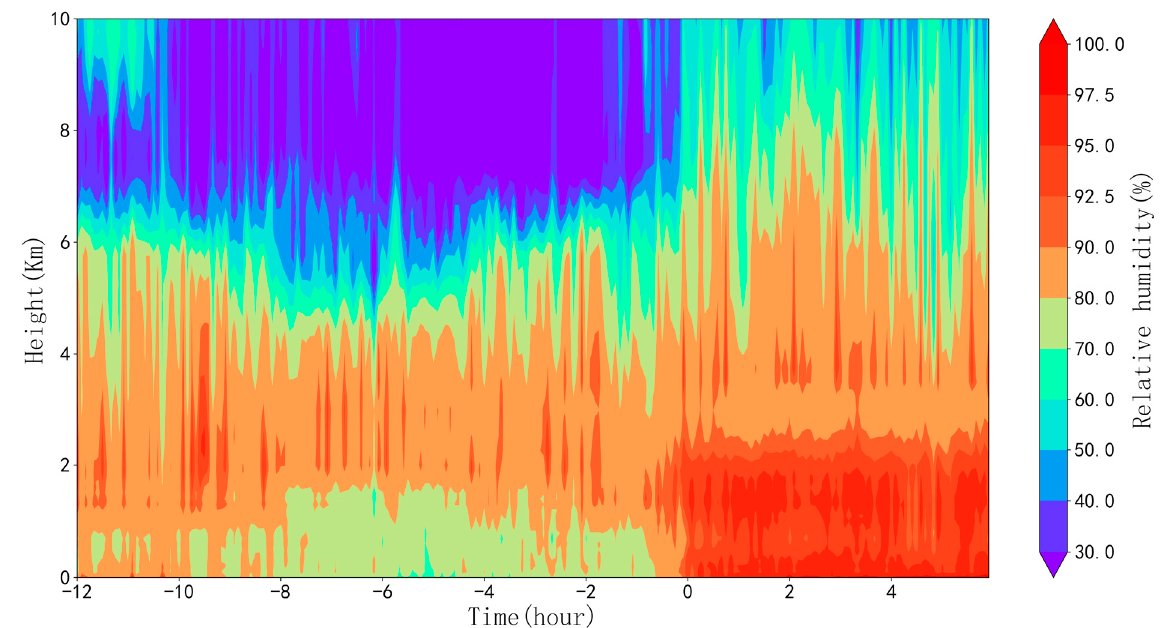
Figure 7. Vertical distributions of relative humidity during 12 h before and 6 h after the start of LDPs in 2021.